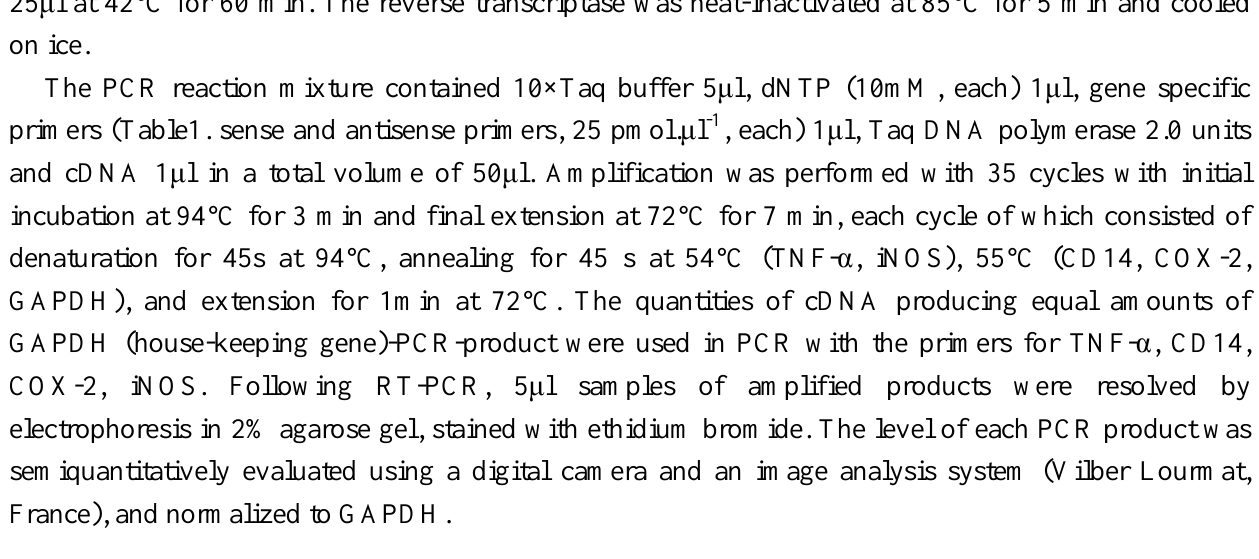
Table 1 . PCR primers for CD14, TNF- α , COX-2, iNOS and